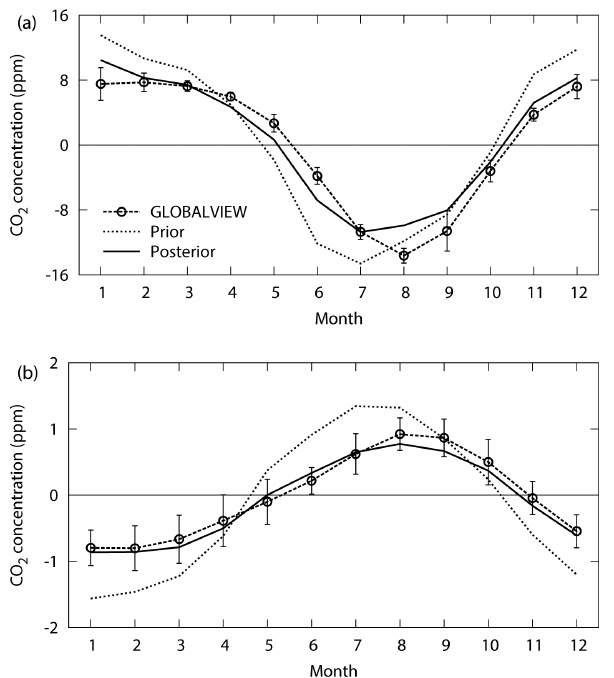
Figure 3. Seasonal variations in the observed and modeled mean monthly CO 2 concentrations (ppm) at (a) University of Maine, USA, and (b) Tierra Del Fuego, Argentina. Open circles with the dashed lines are GLOBALVIEW-CO 2 data, the dotted lines repre- sent the prior parameters, and the solid line represents the posterior parameters. The error bars indicate the uncertainties in the observa- tions.